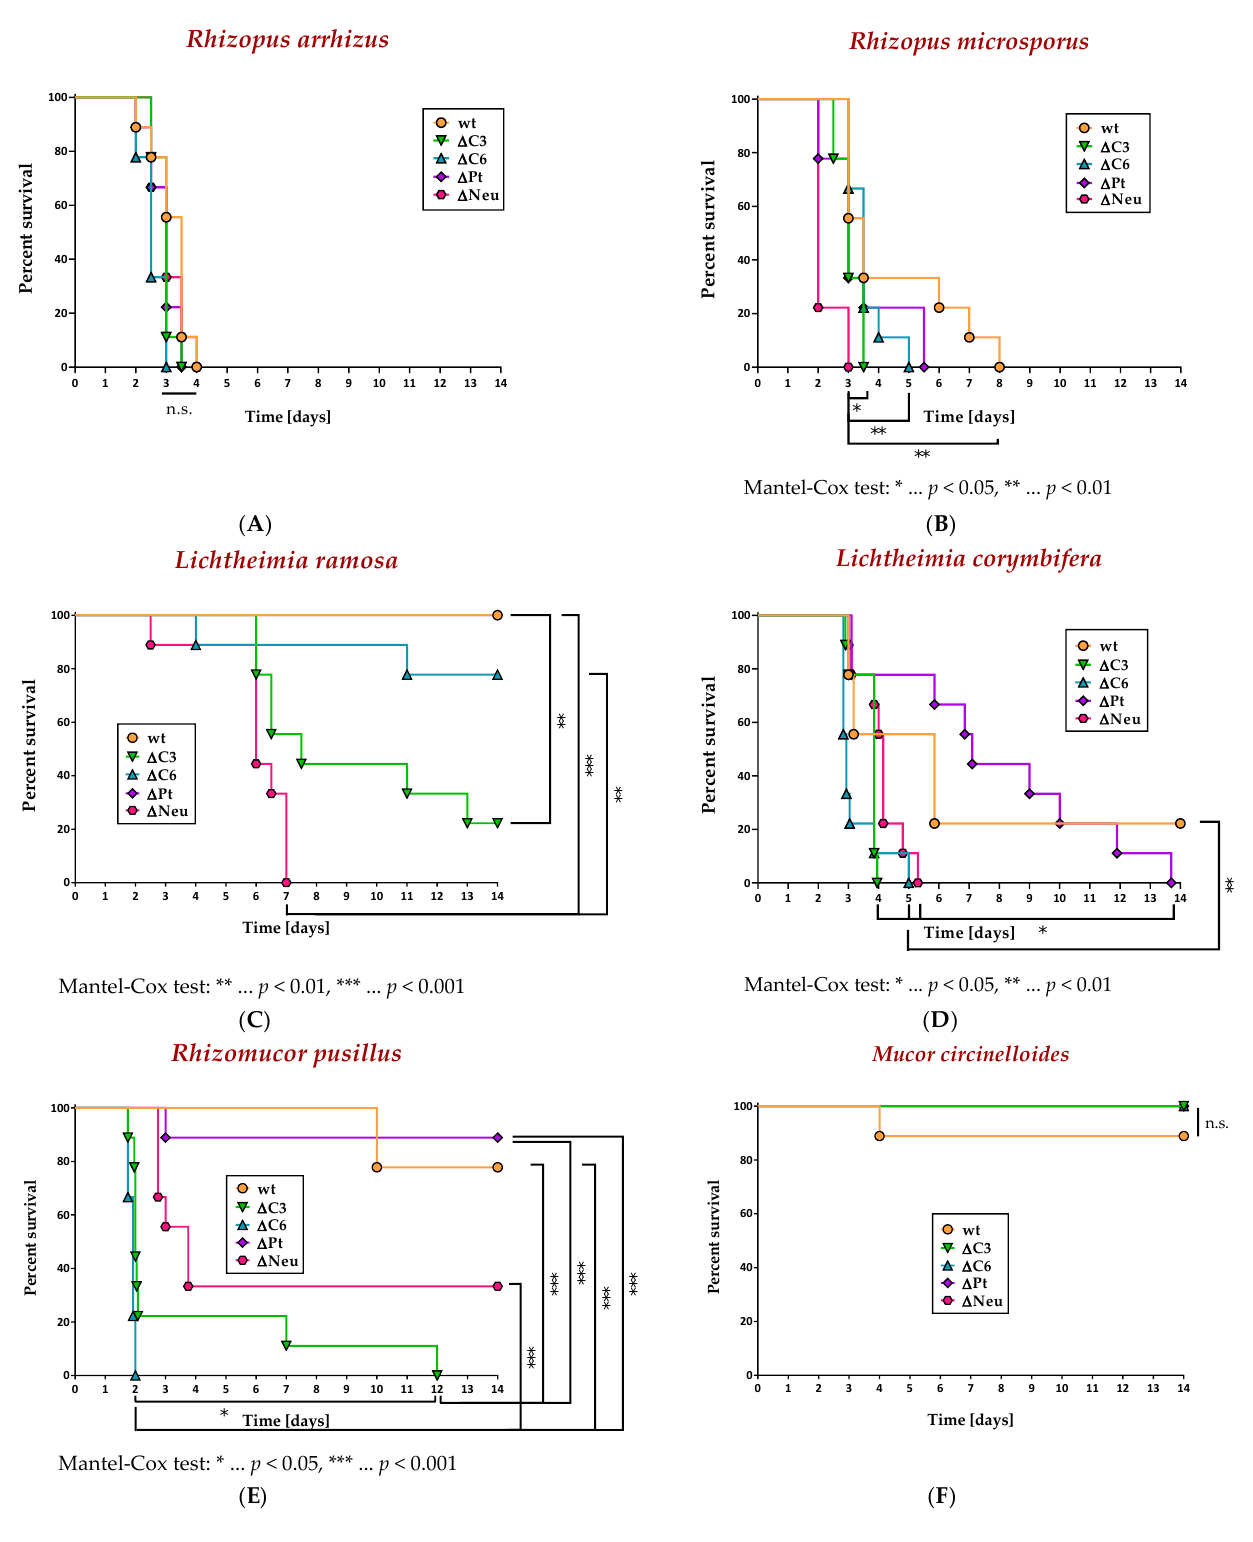
Figure 4. Survival curves in a murine model of disseminated mucormycosis. Immunocompetent (wt, n = 9), C3-deficient ( Δ C3, n = 9), C6-deficient ( Δ C6, n = 9), thrombocytopenic ( Δ Pt, n = 9), and neutropenic ( Δ Neu, n = 9) animals were intravenously challenged with 5 × 10 5 spores of R. arrhizus ( A ), R. microsporus ( B ), L. ramosa ( C ), L. corymbifera ( D ), Rh. pusillus ( E ), or M. circinelloides ( F ). The survival was monitored for 14 days. Asterisks (*) indicate the level of significance for a p -value re- sulting from a Mantel – Cox test analyzing pairs of survival curves.